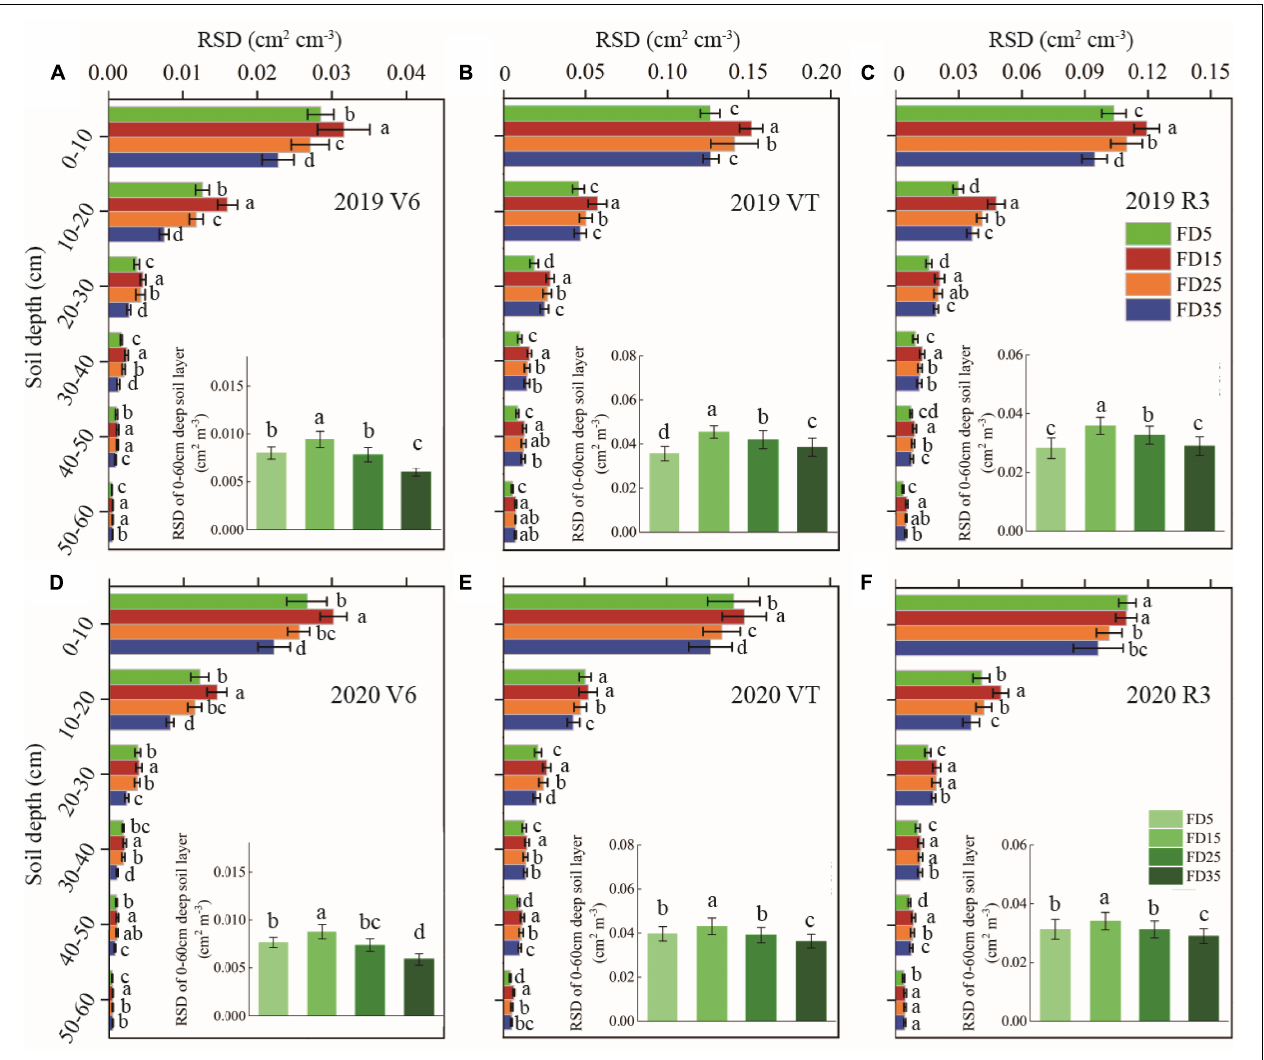
FIGURE 4 | Effects of fertilizer application depths on root surface area density (RSD) at V6, VT, and R3 stages of summer maize in 2019 (A–C) and 2020 (D–F) . FD5, fertilizer application at a depth of 5 cm; FD15, fertilizer application at a depth of 15 cm; FD25, fertilizer application at a depth of 25 cm; and FD35, fertilizer application at a depth of 35 cm. The vertical bars stand for standard deviation. The different lowercase letters indicate a significant difference among the treatments at P < 0.05 using the LSD